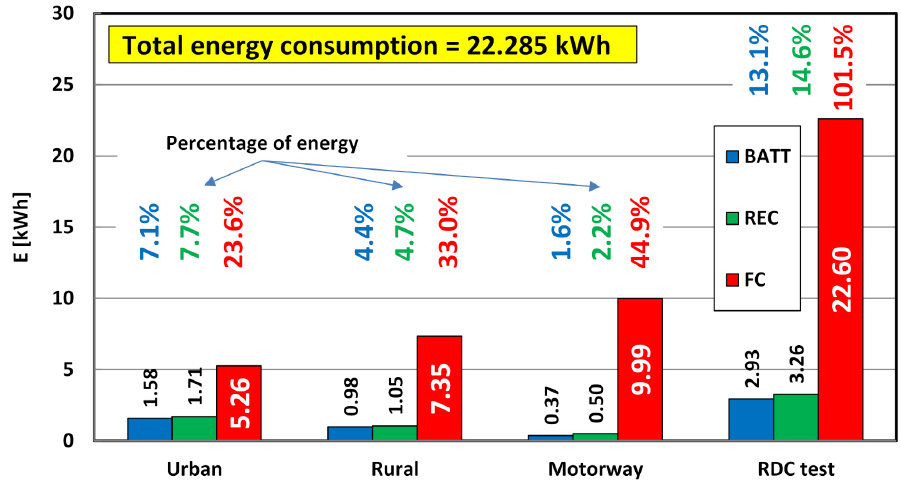
Figure 15. Energy consumption conditions for the RDC test phases and the entire RDC